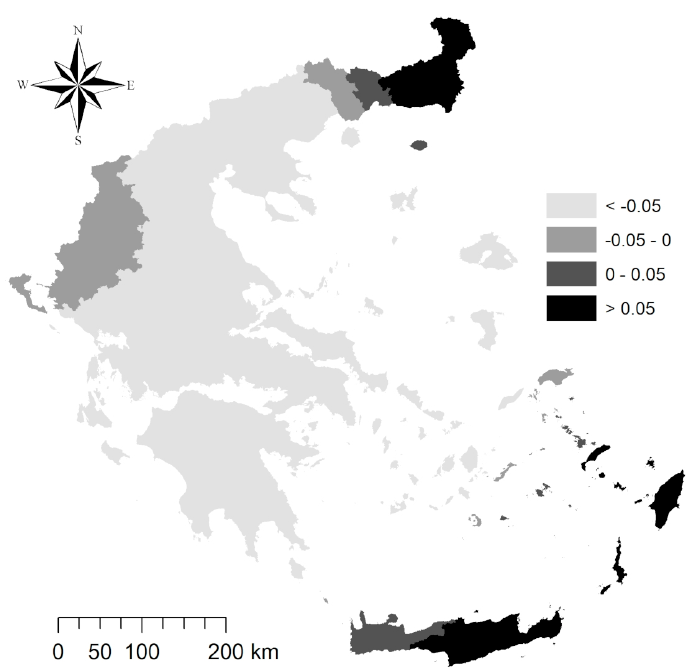
Figure 7. Absolute change in the GWR regression coefficient (local slope) during two consecutive decades in Greece, 1961–1981.